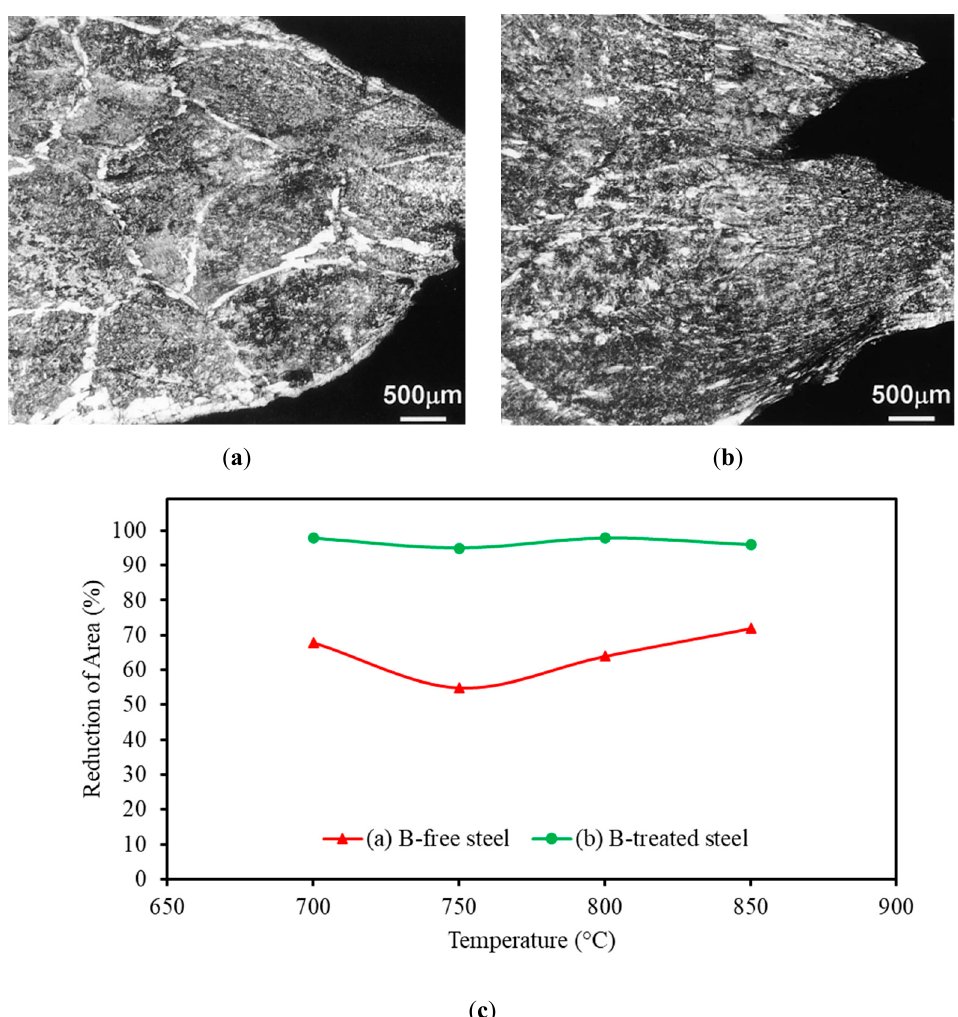
Figure 6. The change in ferrite distribution from the boundaries to the matrix by adding 0.002% B, in samples tested at 750 °C. ( a) No B, ferrite at boundaries; ( b) with 0.002% B addition, ferrite was distributed at the boundaries and within the matrix; ( c) hot ductility curves for the two steels [30]. Adapted from [30], with permission from Elsevier, 2023.